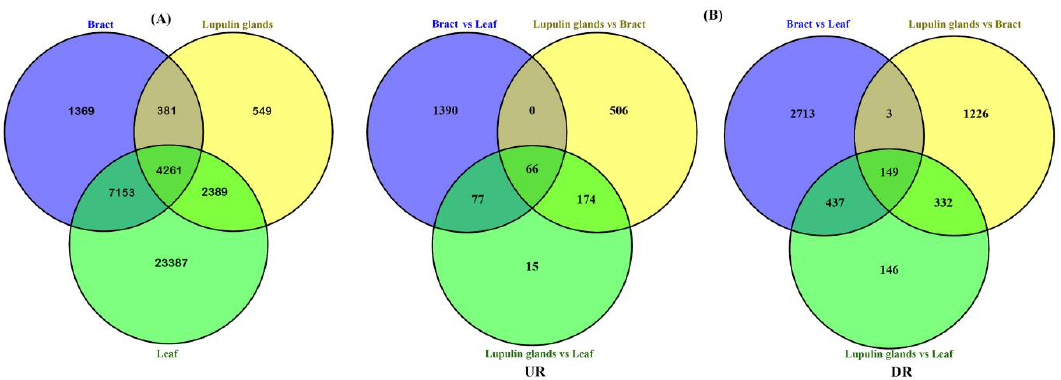
Figure 5. Venn diagram representing the number of unigenes in leaf, bract, and lupulin glands ( A ) and overlap of di ff erentially expressed genes in the pairwise comparison sets of the three stages ( B ). UR: up-regulated, DR: